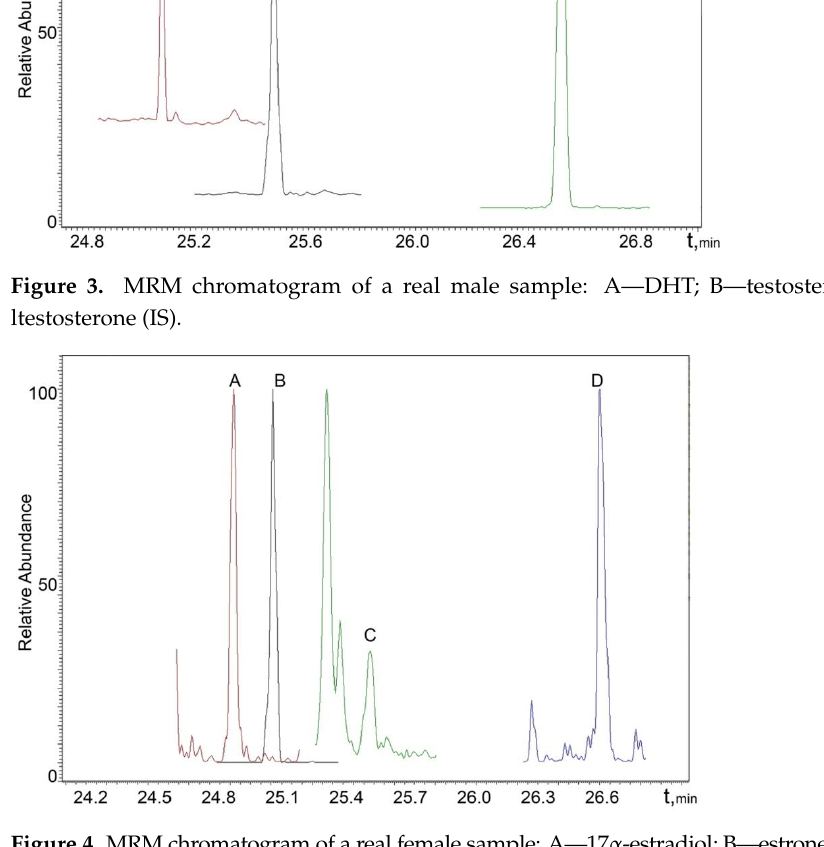
Figure 4. MRM chromatogram of a real female sample: A—17 α -estradiol; B—estrone; C—testosterone; D—methyltestosterone (IS).